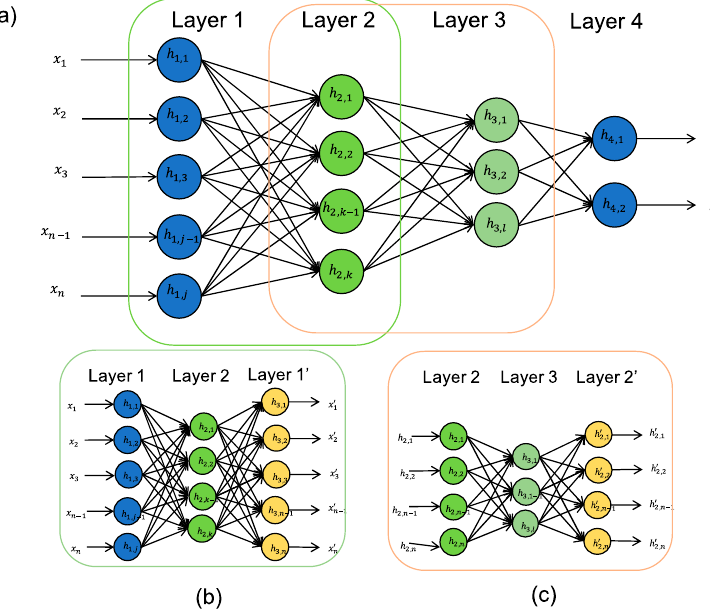
Figure 5. Stacked autoencoder with a classification layer. ( a ) Stacked autoenoder; ( b ) autoencoder for layer 2; ( c ) autoencoder for layer 3.